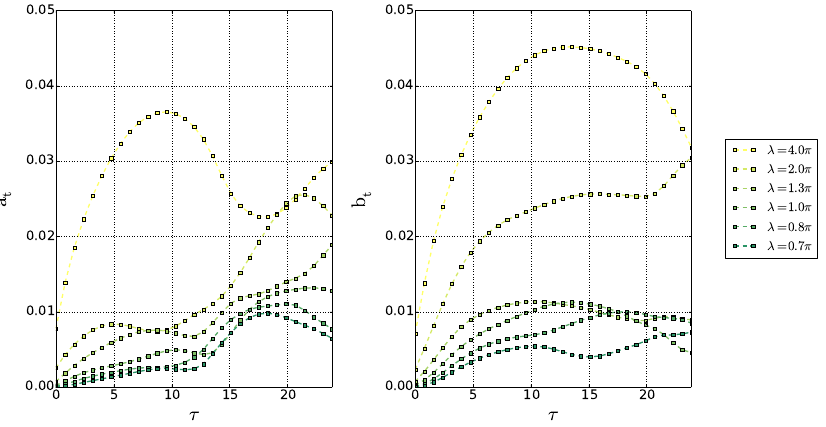
Figure 11. Fourier transform of the lower layer potential vorticity, on the slope, in the case d / R = 3.2, γ R = 1, d c / R = 0. The modal coefficients a n ( t ) and b n ( t ) (Equation (15)) are plotted versus time, for several wavelengths λ = L / n = 4.0 π / n .